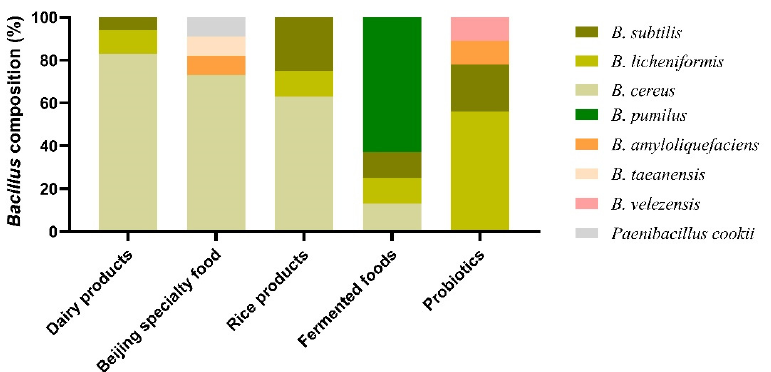
Figure 3. Compositions of Bacillus species in the samples from different sources. B. cereus is the dominant species in the isolates recovered from dairy products, Beijing specialty foods and rice products. B. pumilus and B. licheniformis are the most prevalent groups of fermented foods and probiotics-derived Bacillus strains, respectively.